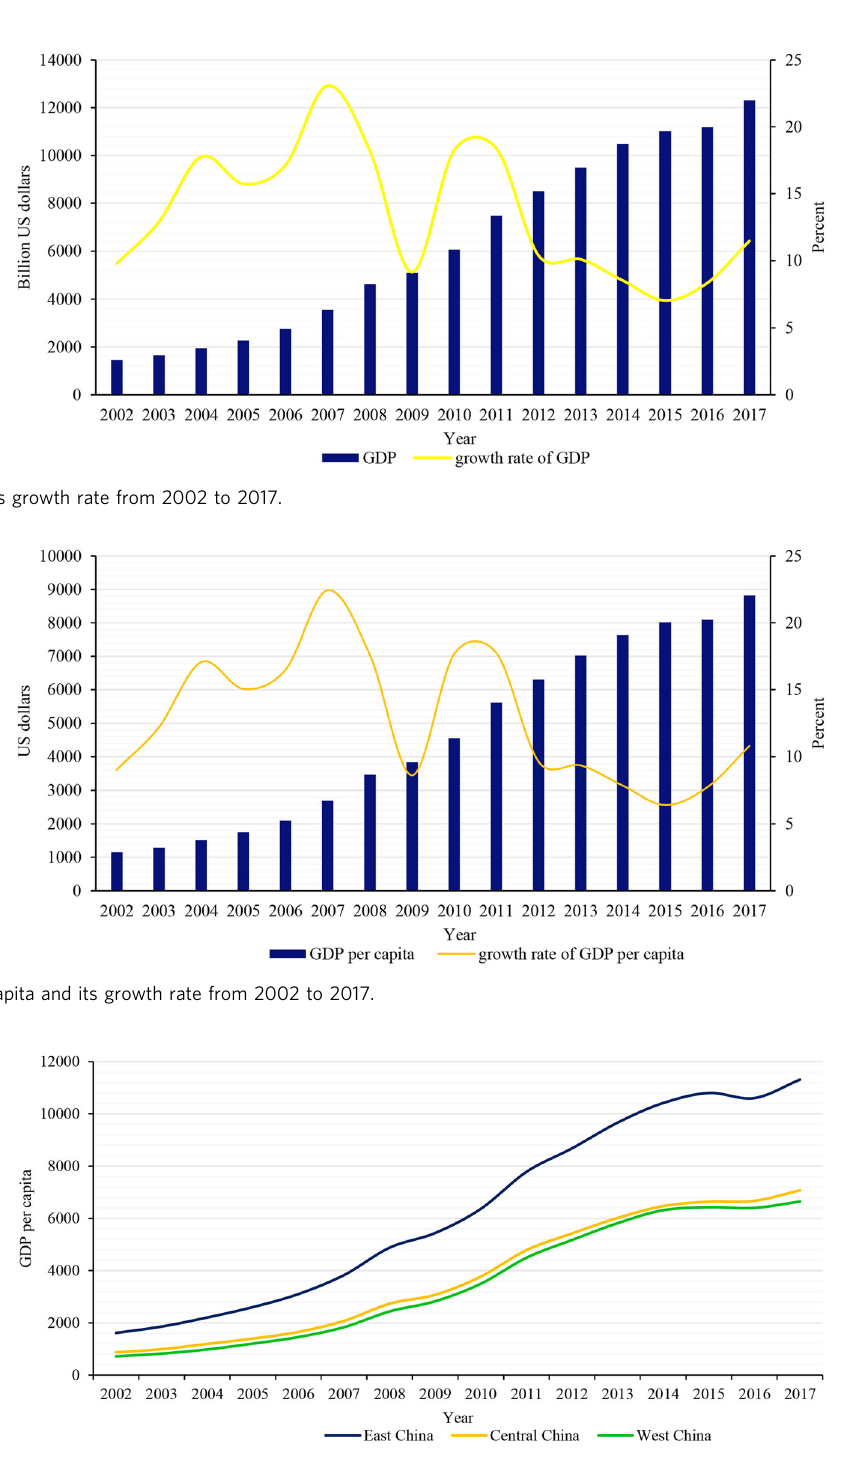
Fig. 3 China ’ s income level in East,Central and West provinces from 2002 to